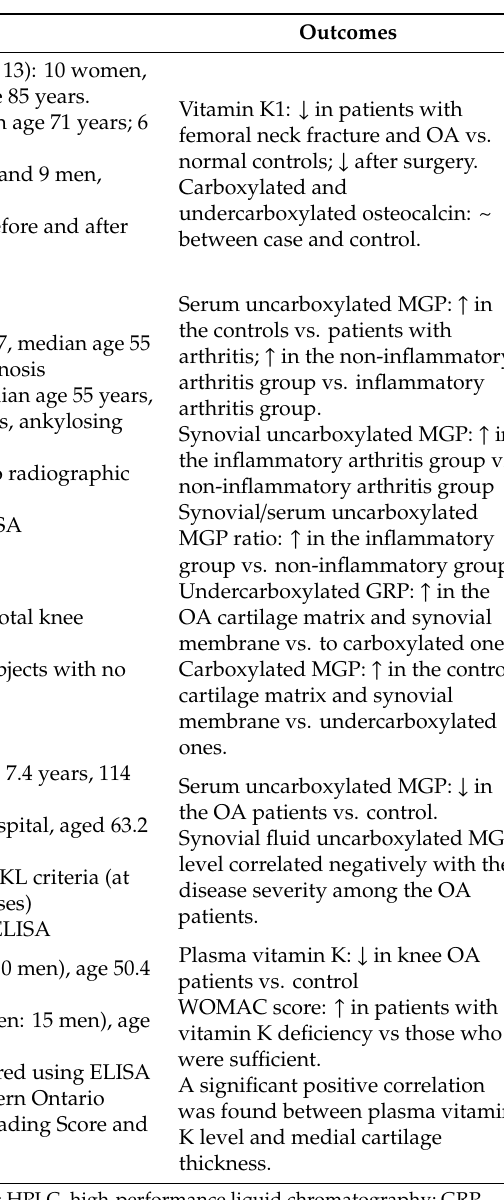
Table 1. The relationship between vitamin K status and OA from case-control